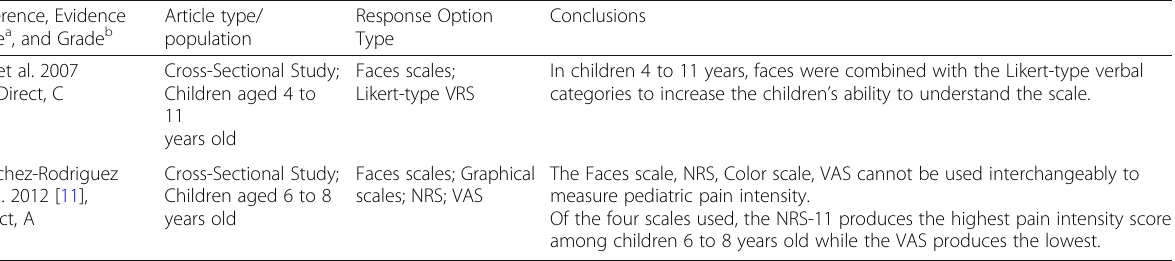
Table 3 Summary of key evidence to support response scale selection for children 4 to 8 years